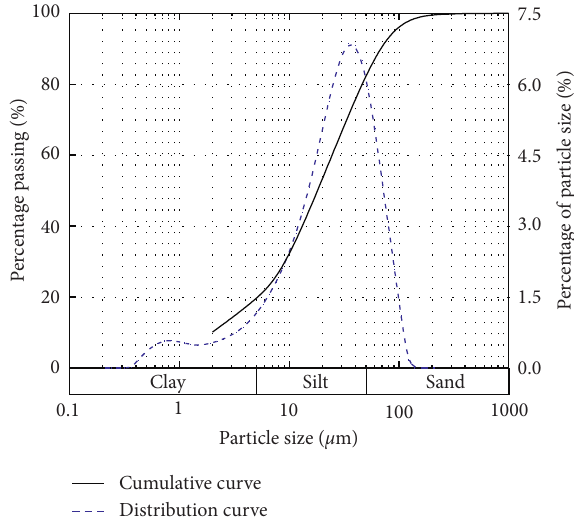
Figure 1: Grain size distribution curve of the loess.